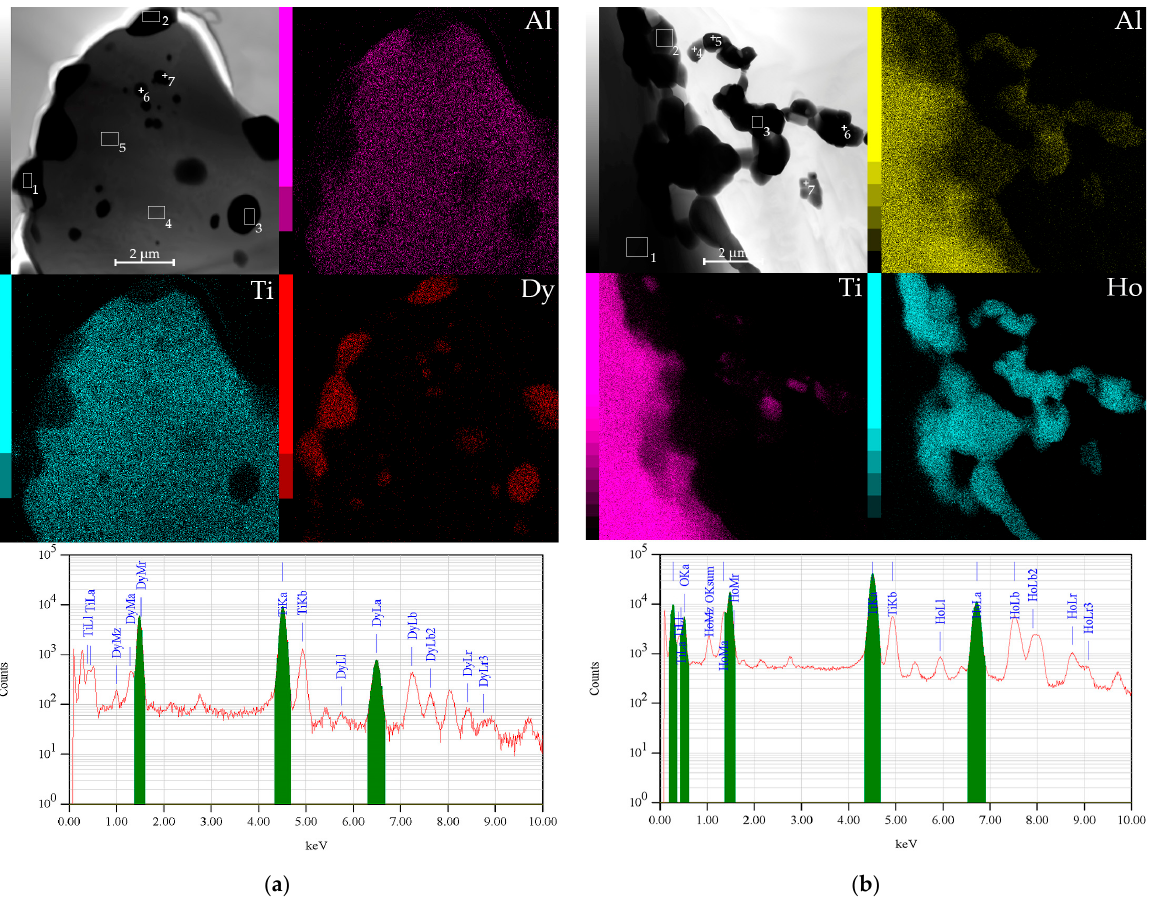
Figure 4. Transmission electron microscopy (TEM) images with super-spectral surface and with energy-dispersive spectral analysis (EDS) spectrum of relevant areas: the TAD alloy ( a ); the TAH ( b ) alloys.